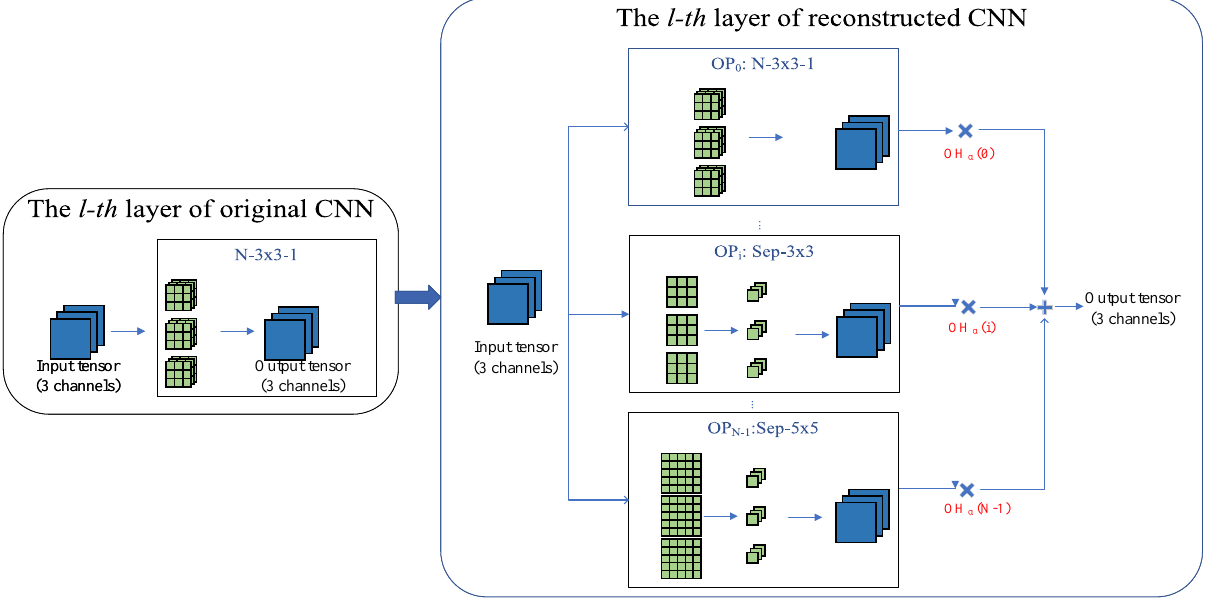
Figure 1. Reconstruction of the original CNN. We expand each layer (convolution layer or pooling layer) into N parallel branches and multiply a trainable mask to each branch. In this figure, OH α is a one-hot mask vector generated by α . Each element of OH α can only be 0 or 1 and only one element can be 1. OH α can be trained using gradient descend. α is defined as architecture parameter. The layer index of α is omitted which should be α l for the lth layer. The blue squares represent input or output tensors (with 3 channels for better presentation) and the green squares represent weights of convolution layers. Only three operators are presented in the figure, and more lightweight operators are shown in Appendix